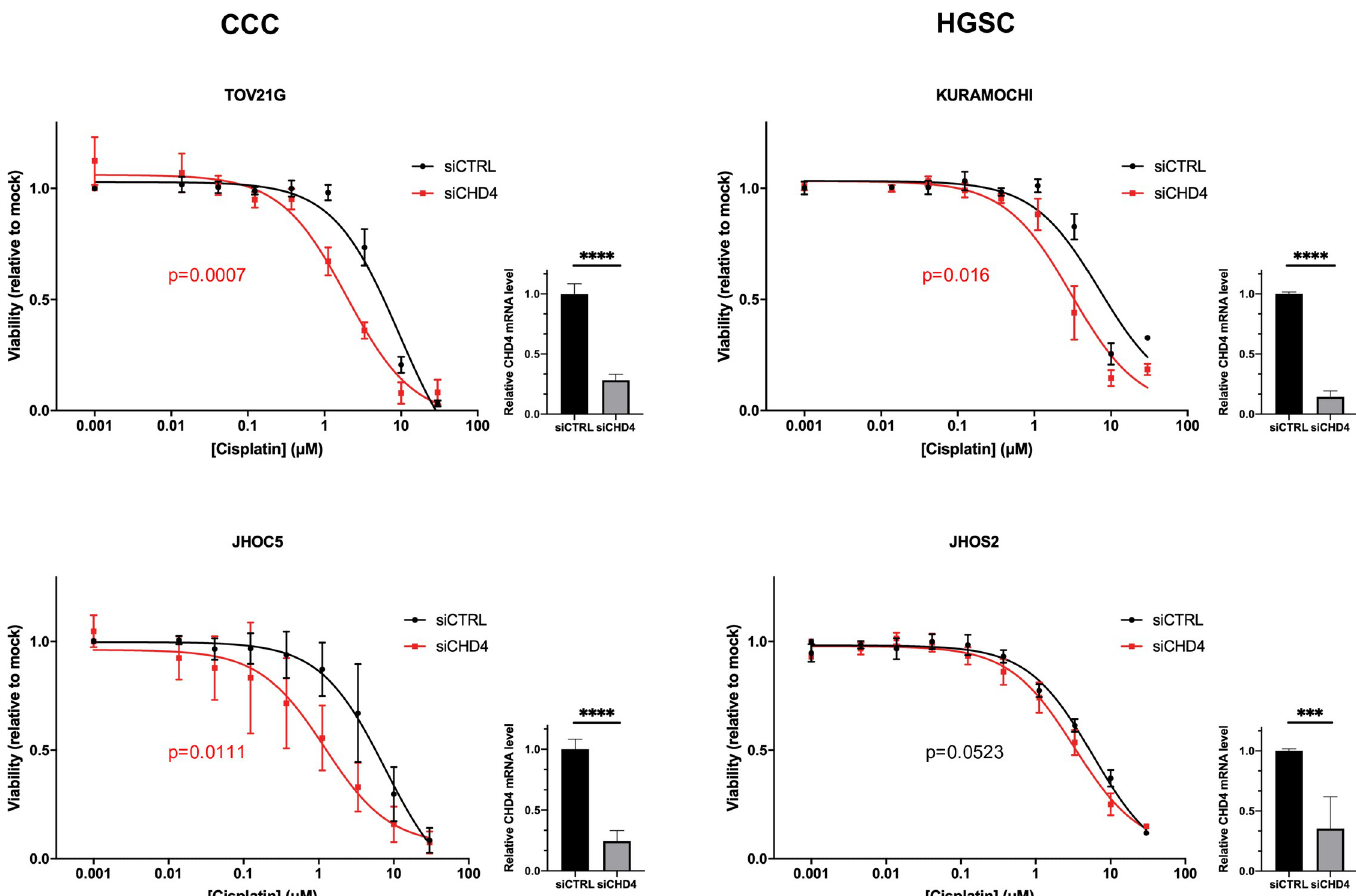
Fig 2. Inhibition of CHD4 expression increases platinum sensitivity in ovarian cancer cell lines. Dose-response curves for 72 hours of cisplatin treatment in TOV21G, JHOC5, KURAMOCHI, and JHOS2 after 72 hours of CHD4 siRNA or negative control siRNA transfection. The curves represent the average values of at least three independent experiments. IC50 between samples with CHD4 siRNA transfection and control siRNA transfection was compared using Student’s t -test. The efficiency of CHD4 knockdown was validated using quantitative PCR in all the cells. ��� p � 0.001; ���� p � 0.0001. siCTRL; negative control